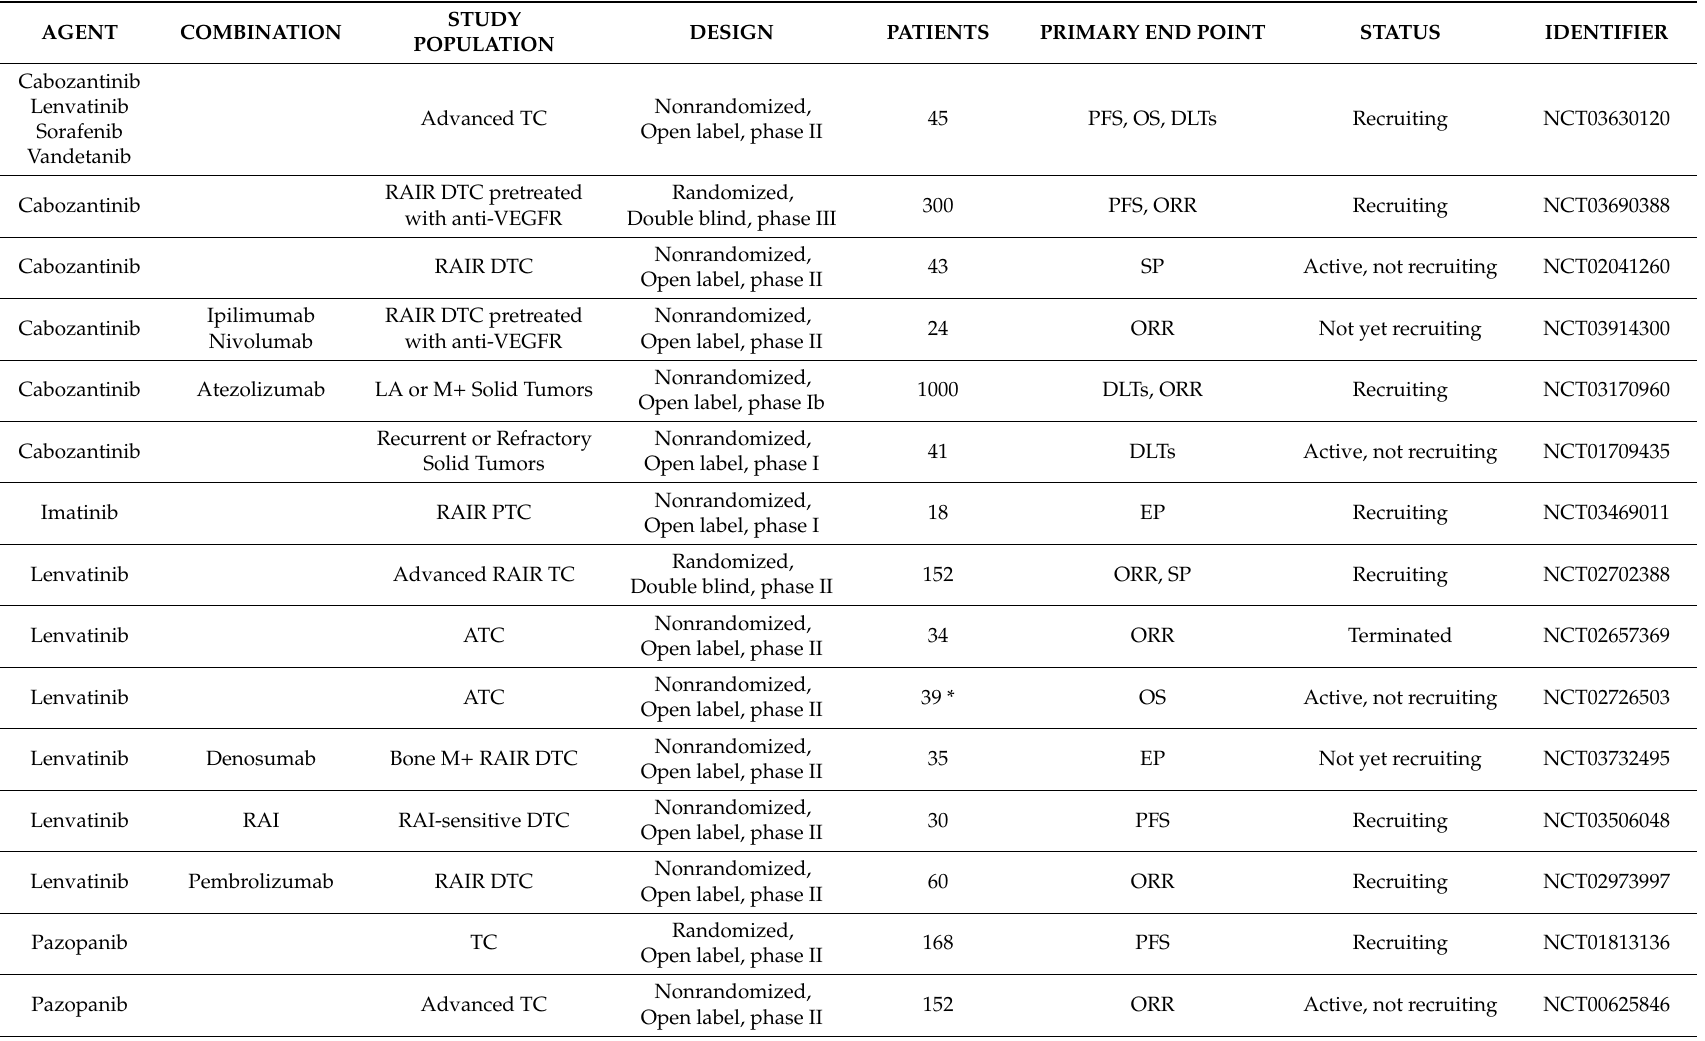
Table 1. Clinical trials with multi-kinase